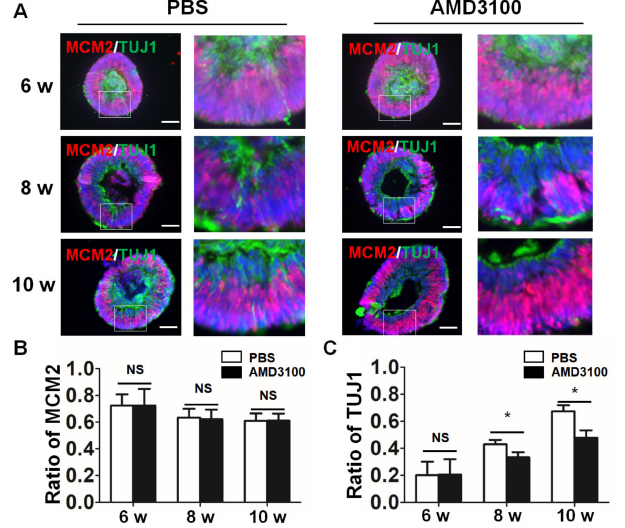
10 weeks (6 weeks: PBS, not detected, AMD3100, not detected; 8 weeks: PBS,